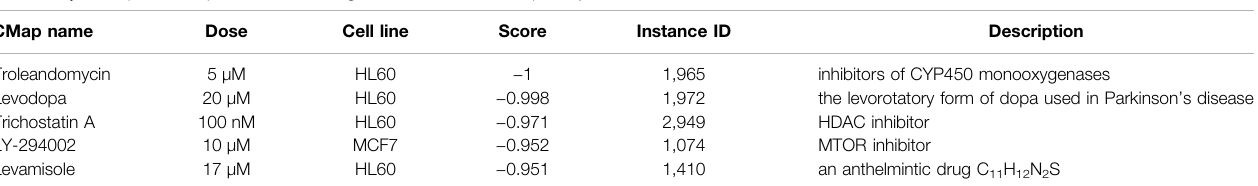
TABLE 5 | The top fi ve compounds with the highest scores in the CMap analysis.